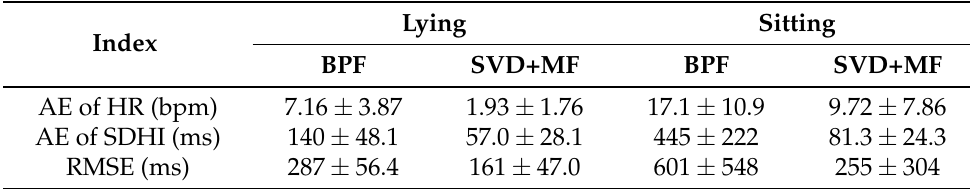
Table 4. Comparison of heart rate estimation accuracy against subject’s